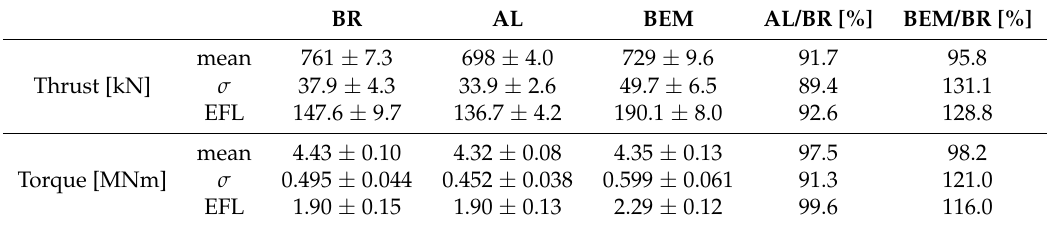
Table 2. Thrust and torque comparison by mean, standard deviation σ and EFL between BR, AL and BEM. BR AL